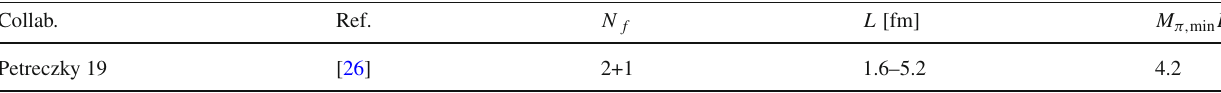
Table 100 Finite-volume effects in the determinations of m b with N f = 2 + 1 quark flavours Collab.